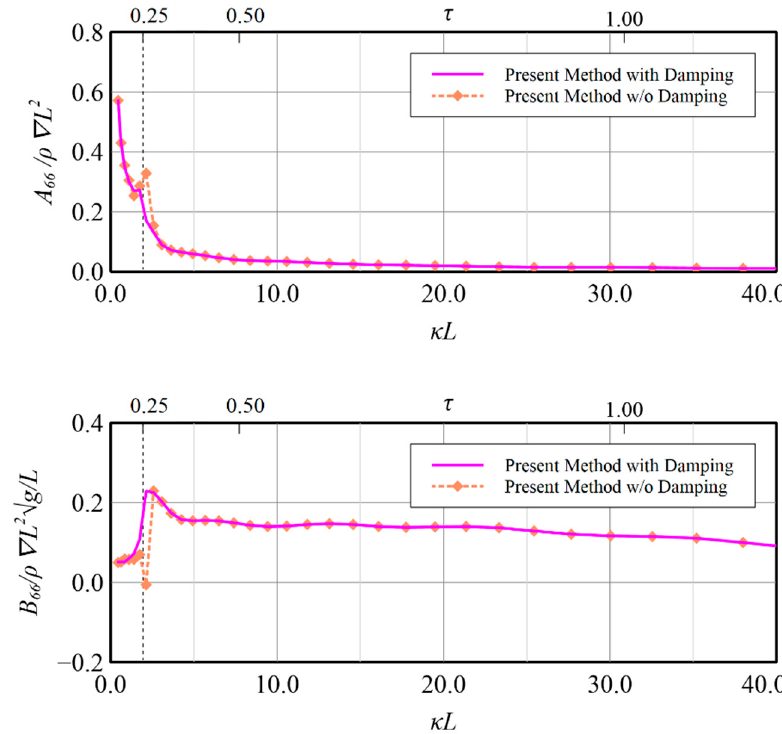
Figure 22. Yaw-induced-yaw added mass and damping coefficient at F r = 0.18.